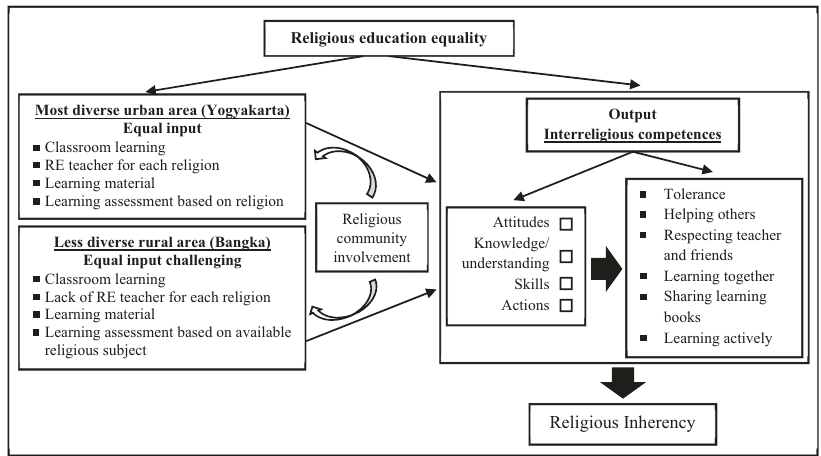
Fig. 5 Research framework. The relationship root of religious inherency and interreligious competence in RE